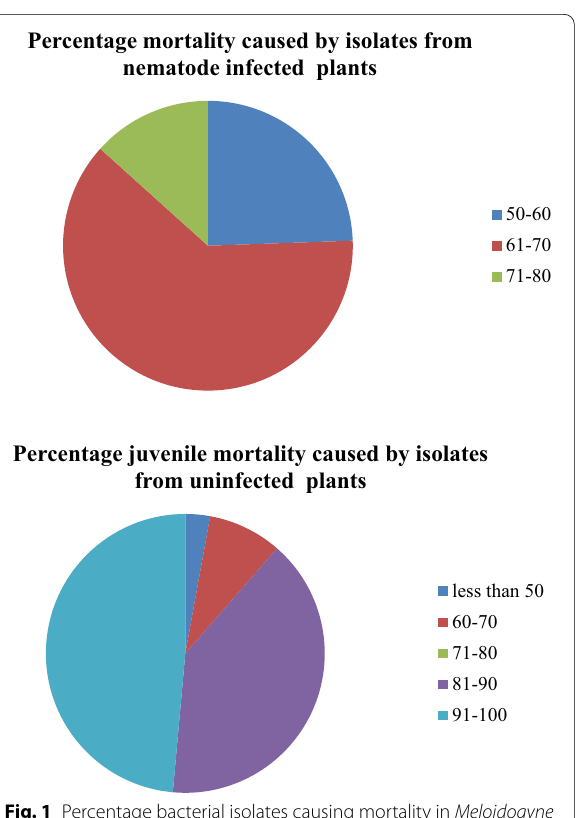
Table 2 Rhizobacterial isolates and their identity based on 16S rRNA gene sequence similarity S.